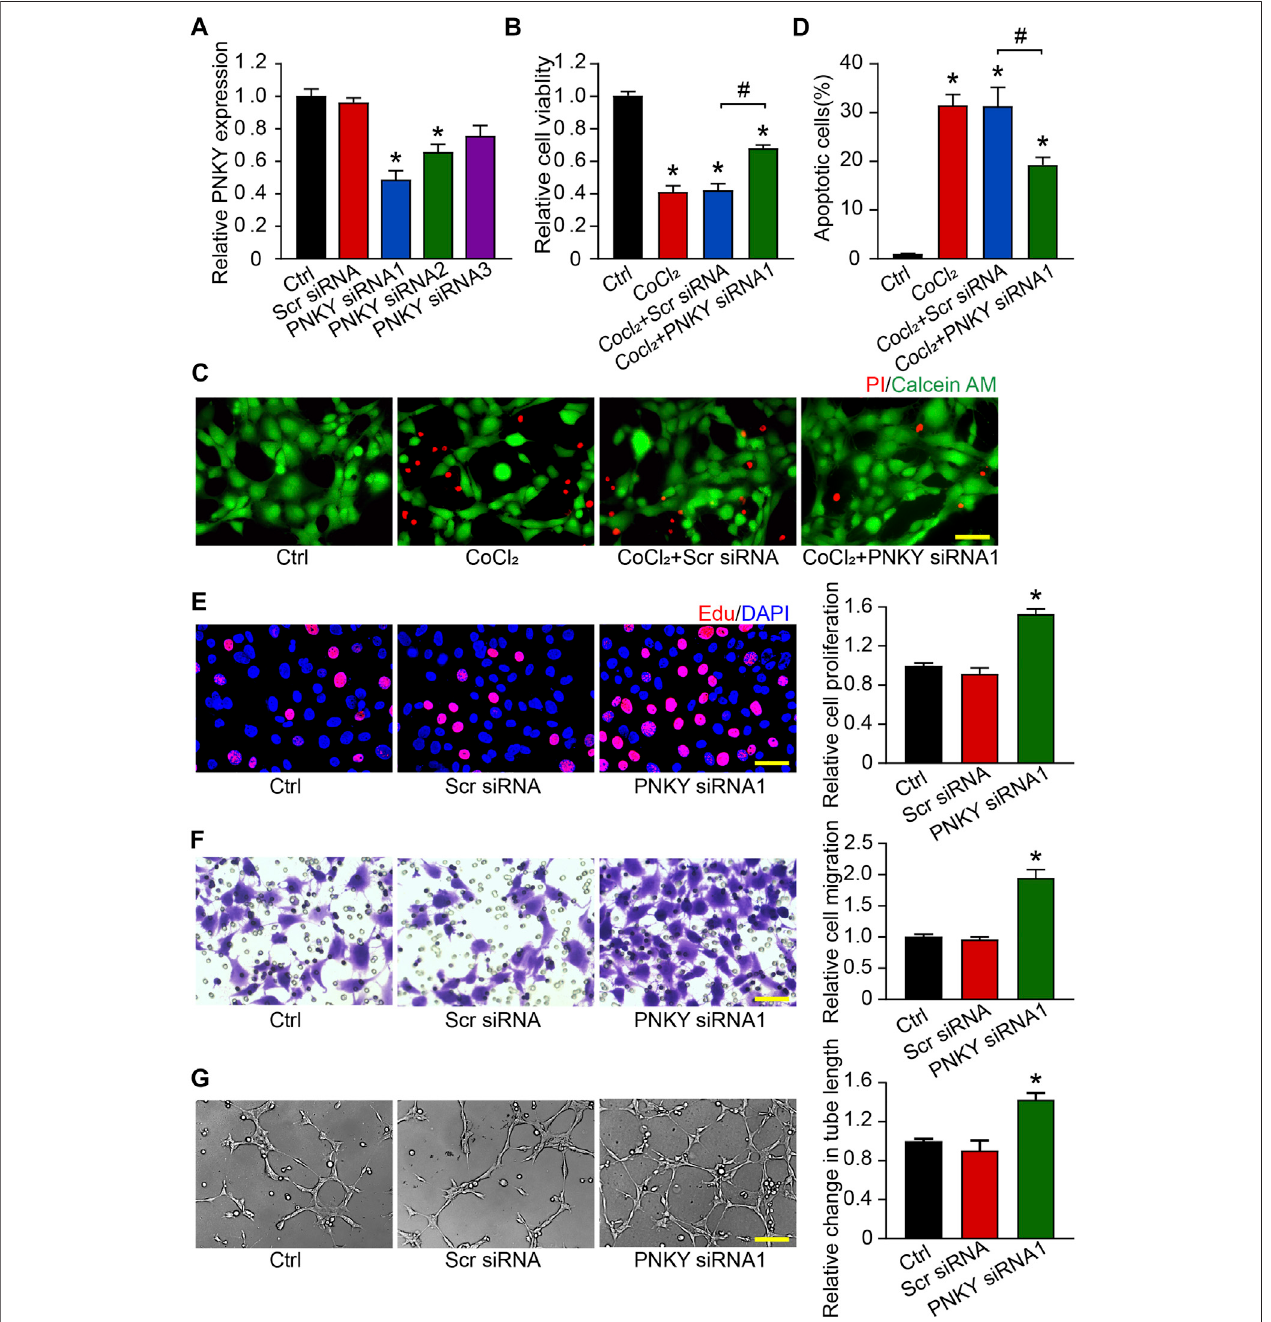
FIGURE4| LncRNAPNKYregulatesendothelialfunction invitro .RF/6Acellsweretransfectedwithscrambled(Scr)siRNA,PNKYsiRNA1,orleftuntreated(Ctrl)for 24 h before further processed. (A) qRT-PCRs were conducted to detect PNKY expression ( n = 4). RF/6A cells were exposed to 200 μ M CoCl 2 to mimic hypoxic stress for 24 h. (B) Cell viability was detected using MTT method ( n = 4, * p < 0.05 versus Ctrl). (C,D) The group without CoCl 2 treatment was taken as the control group. ApoptoticcellsweredetectedbyPI/Calcein-AMstaining.Green:livecells;red:deadordyingcells(Scalebar,50 μ m, n =4,* p < 0.05versusCtrl). (E) EdUdetection kit(RiboBio,Guangzhou,China)wasusedtotestcellproliferationbyanalyzingtheincorporationofEdUinDNAsynthesis.Blue:DAPI;red:EdU(Scalebar,50 μ m, n =4). (F) TranswellassaywasperformedtomeasuremigrationofRF/6Acells.Quanti fi cationrevealedthecellsmigratingthroughthetranswell(Scalebar,50 μ m, n =4). (G) To observethe tube-like structures, RF/6Acells were seeded on the Matrigelmatrix. Furthermore, 4 h after cell seeding, average length oftube formation for each fi eld was statisticallyanalyzed(Scalebar,200 μ m, n =4).Allsigni fi cantdifferencewasdeterminedbyone-wayANOVAfollowedbyBonferroni ’ sposthoctest.* p < 0.05versusScr siRNA, # p < 0.05 between the marked